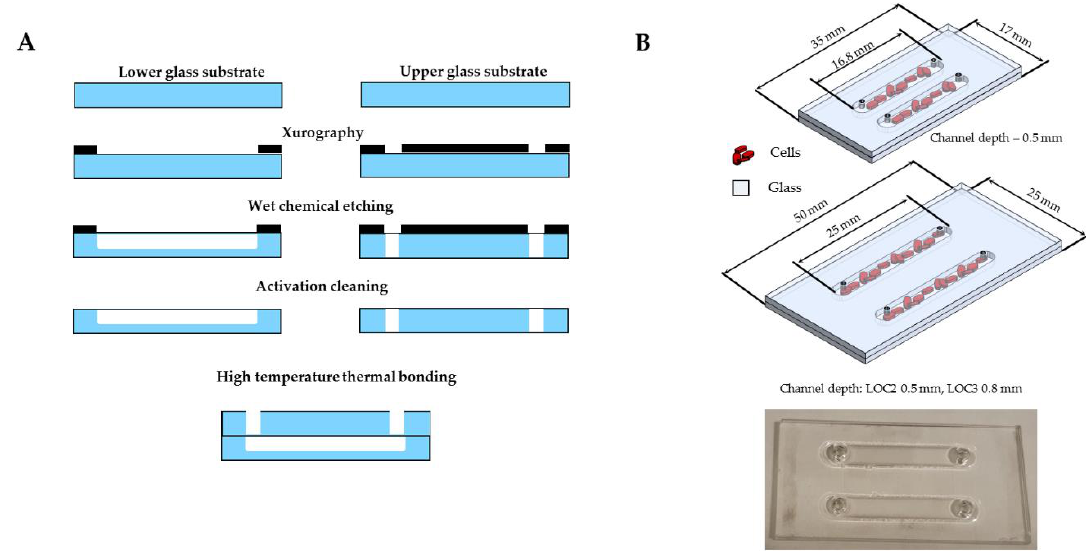
Figure 6. Fabrication of all-glass LOCs (cross-section view), technology flow ( A ); the structure of the prepared LOCs ( B ).